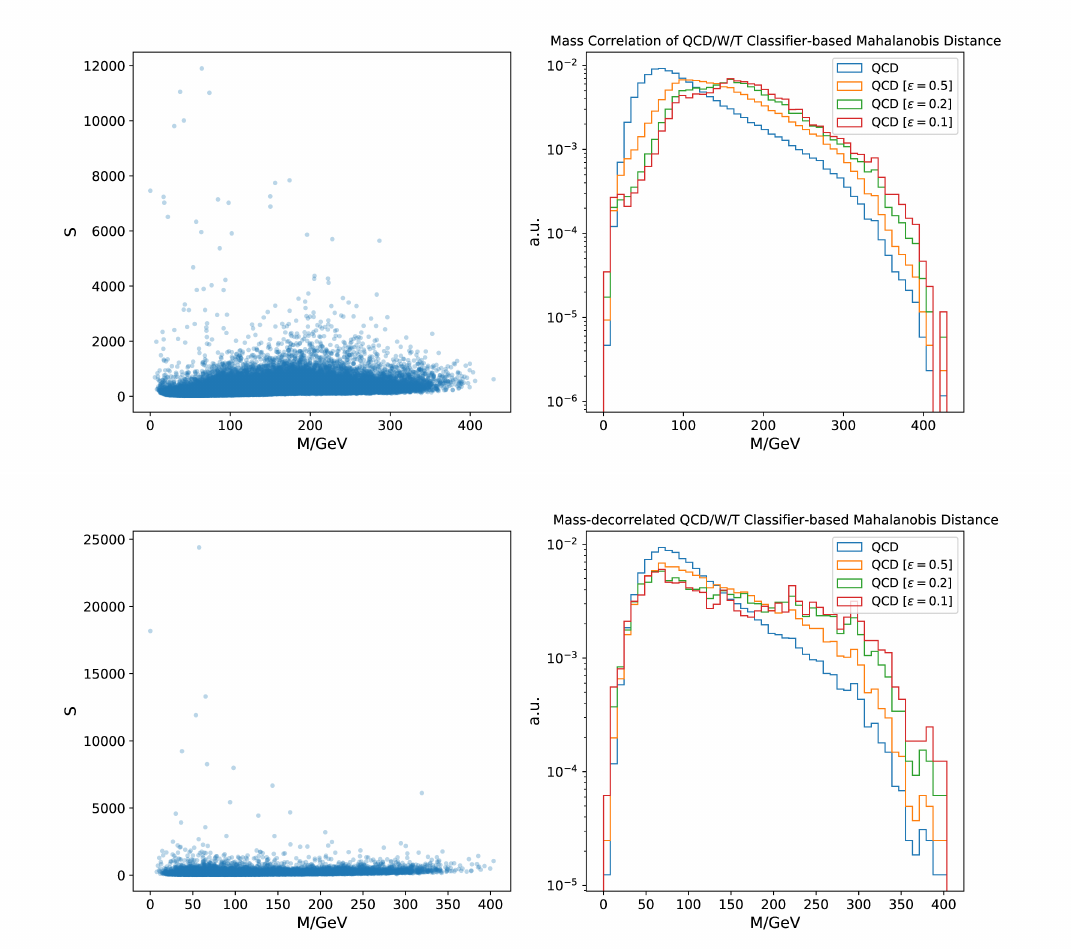
Figure 7 . Top : The un-decorrelated model with the Mahalanobis distance as the anomaly score. Bottom : The mass-decorrelated model with the Mahalanobis distance as the anomaly score. Left : The correlation between jet mass M and the anomaly score. Right : Mass distributions for different background acceptance rates ( (cid:15)